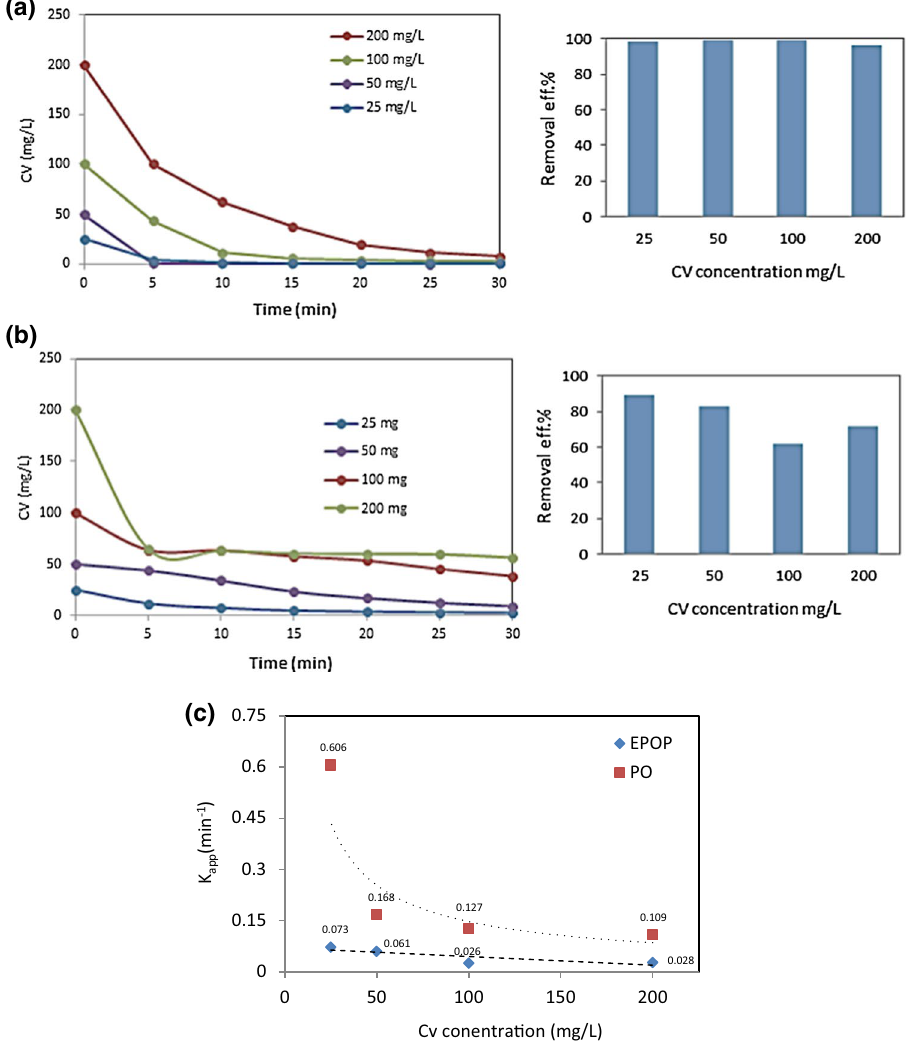
Fig. 4 Effect of initial CV concentrations on peroxone a and e-peroxone/H 2 O 2 efficiency b and apparent decolorization rate c [condition: reactor vol- ume 500 cc and 70 rpm, applied current 0.1 A, NaCl 100 mg/L, pH 9, ozone 2 mg/L. min and